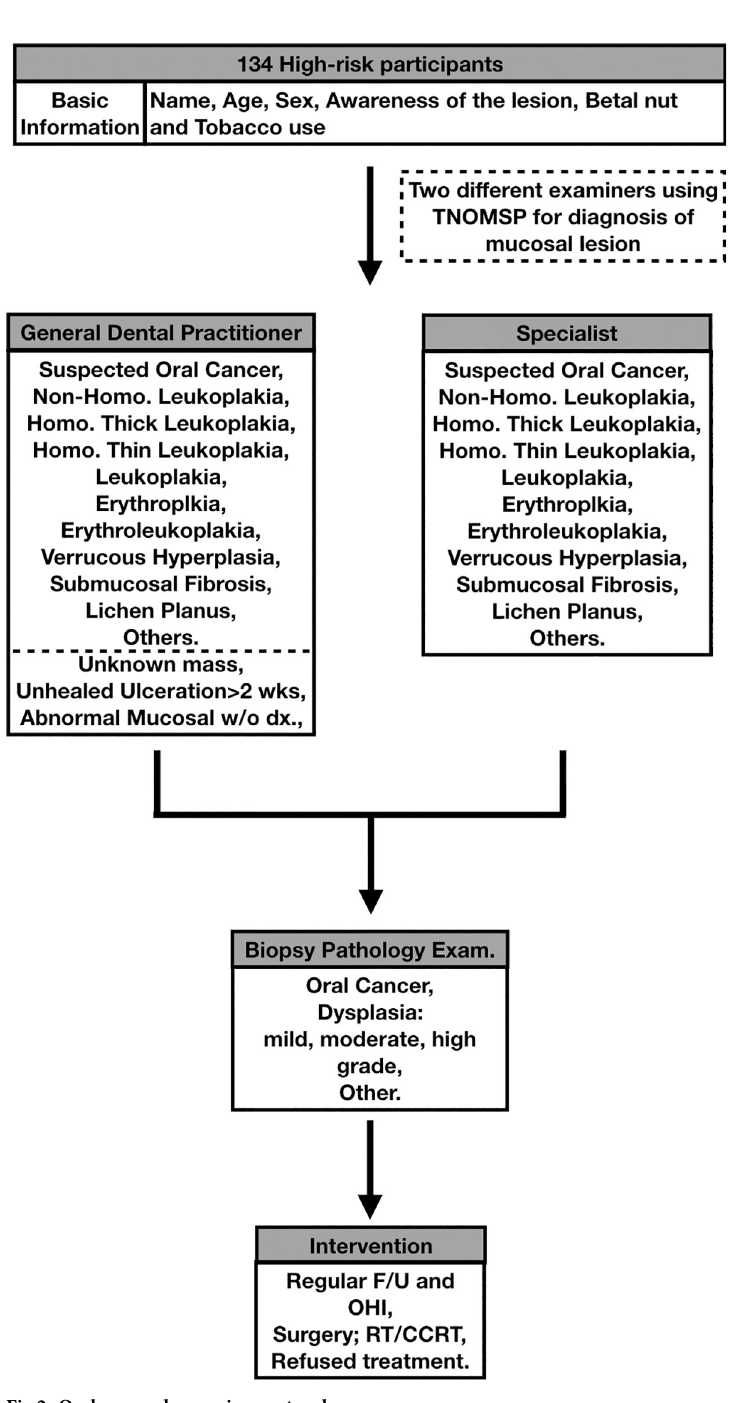
Fig 2. Oral mucosal screening